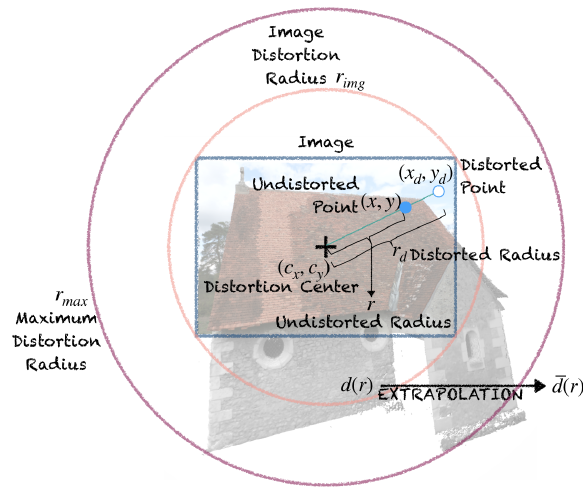
Figure 4. Visual depiction of defined radial distortion model.